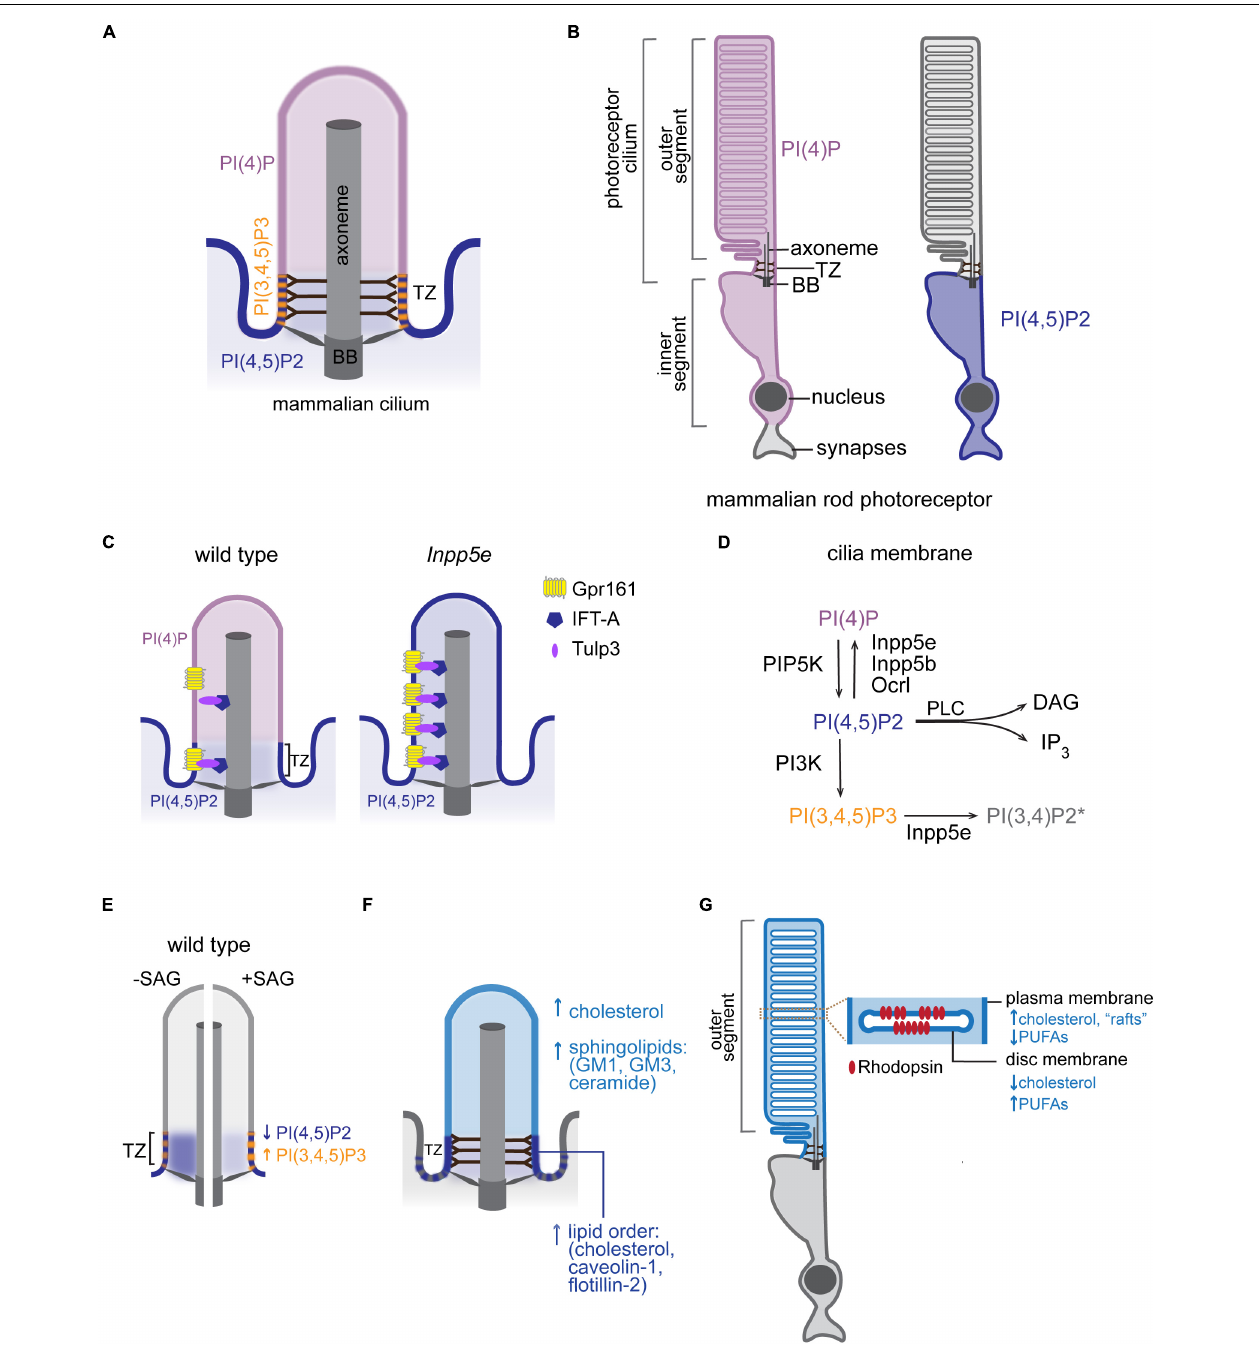
FIGURE 2 | Lipid composition of the ciliary membrane. (A) Schematic representation of PPI distribution in the ciliary membrane of mammalian cells. BB, basal body; TZ, transition zone. (B) Distribution of the indicated PPI species in rod photoreceptors of mammalian retina. (C) Intraciliary localization of PI(4)P and PI(4,5)P2 in mammalian wild-type and Inpp5e mutant cells. Distribution of Tulp3/IFT-A trafficking complex and its GPCR cargo in control and Inpp5e mutant cells is also shown. (D) PPI species and a subset of PPI metabolizing enzymes that have been reported inside cilia. The presence of PI(3,4)P2 in the ciliary membrane is inferred based on intraciliary localization of Inpp5e and its substrate PI(3,4,5)P3 (Moore et al., 2016; Dyson et al., 2017). DAG, diacylglycerol, IP 3 , inositol 1,4,5-trisphosphate, PLC, phospholipase C. (E) Diagrammatic representation of changes in PPI composition at the TZ in response to Hh pathway activation. Blue and orange arrows mark direction of the observed changes in PI(4,5)P2 and PI(3,4,5)P3 levels, respectively, in the wild-type SAG-treated or untreated control cells. (F) A schematic representation of major raft-associated components (proteins and lipids) known to be enriched in the ciliary membrane. Dashed lines at cilia base represent condensed lipid microdomains detected by Laurdan microscopy in some cell types. (G) A schematic diagram of the mammalian rod photoreceptor. Inset shows an enlarged view of the disc and surrounding OS plasma membrane highlighting their distinct lipid content. PUFAs, polyunsaturated fatty acids.